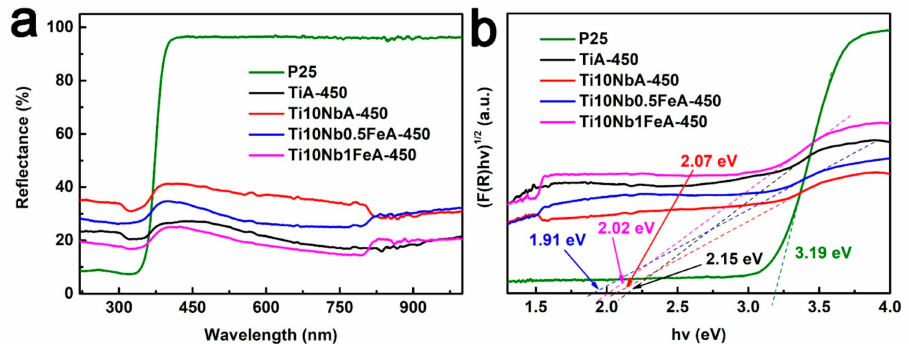
Figure 9. UV-vis diffuse reflectance spectra ( a ) and determination of the indirect interband transition energies ( b ) of P25, TiA-450, Ti10NbA-450, Ti10Nb0.5FeA-450 and